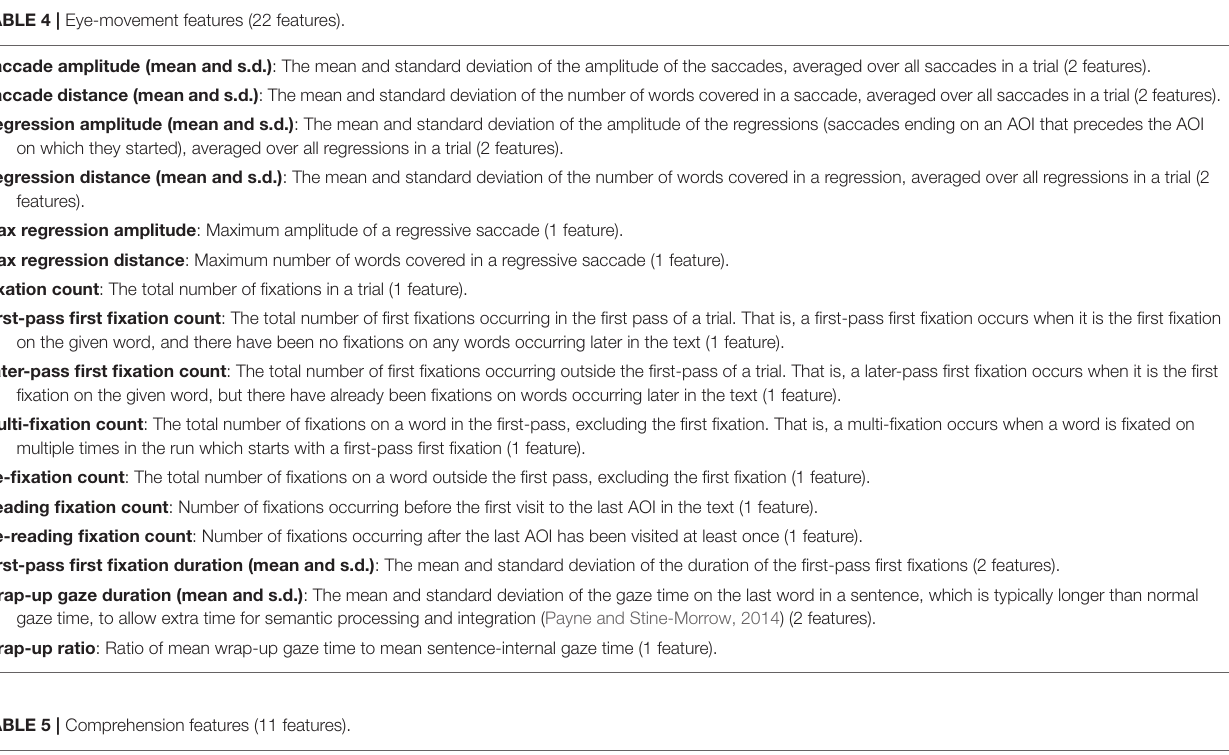
TABLE 4 | Eye-movement features (22 features).